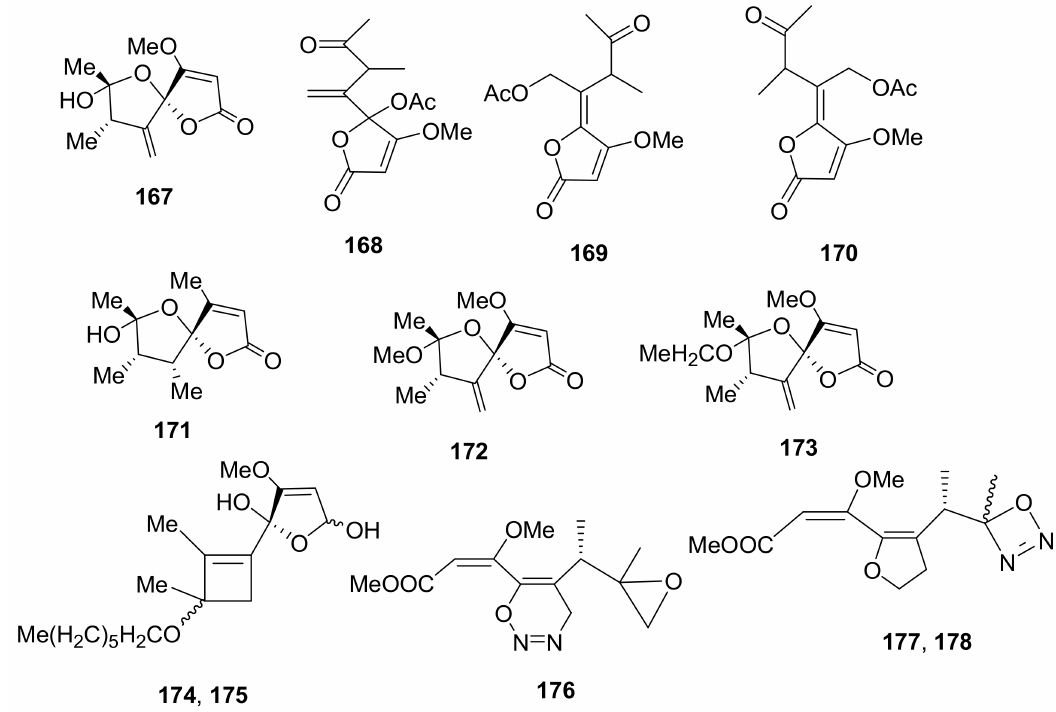
Figure 11. The structures of papyracillic acid ( 167 ) and some of its derivatives ( 168 – 178